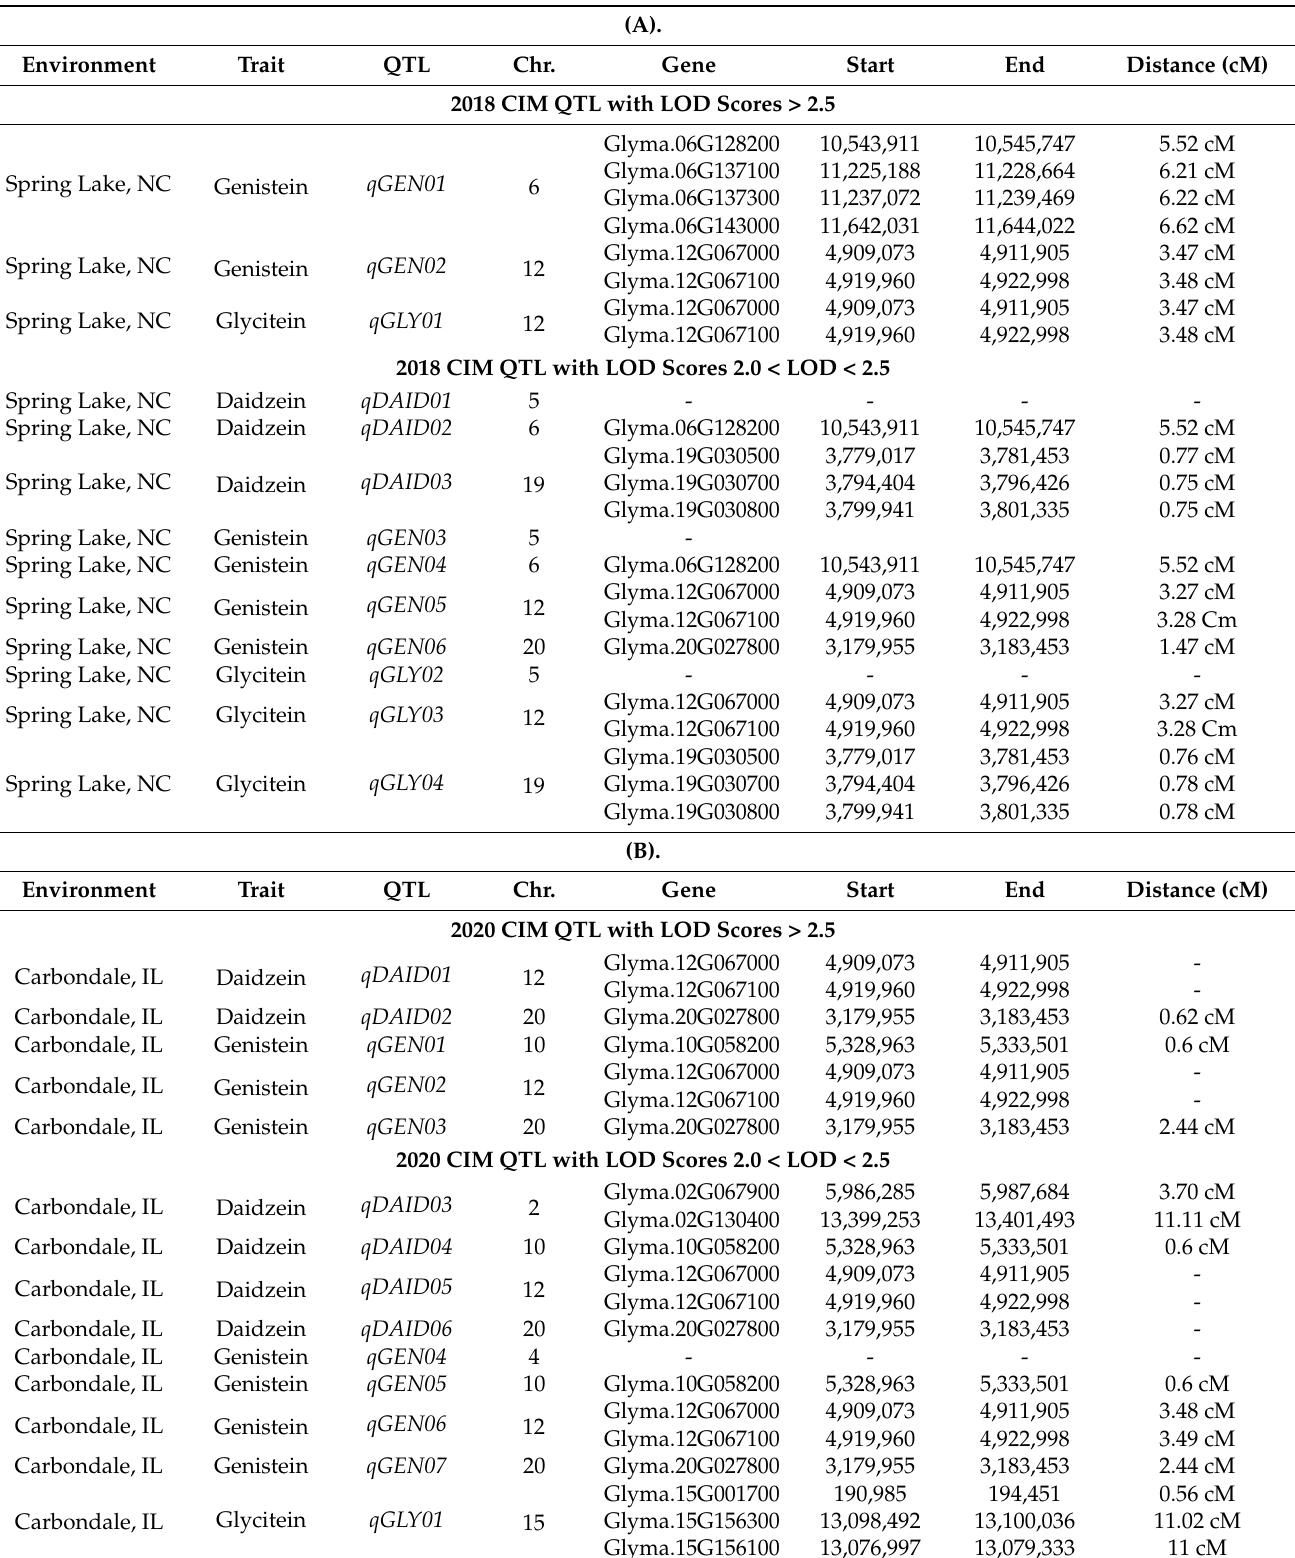
Table 5. Isoflavone candidate genes located within or close to the isoflavone QTL identified in the FxW82 RIL population two environments over two years (A. Spring Lake, NC (2018) and B. Carbondale, IL (2020)).